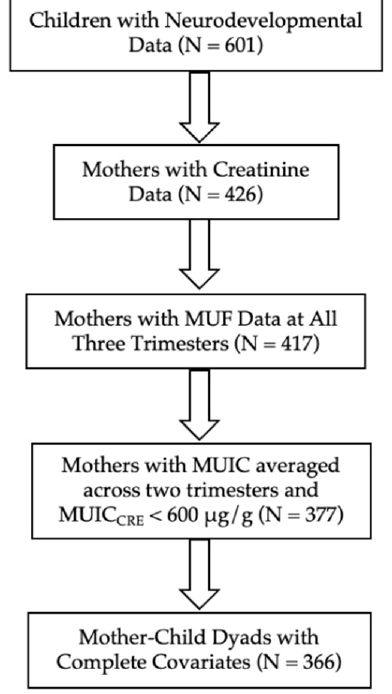
Figure 1. Sample flow chart.